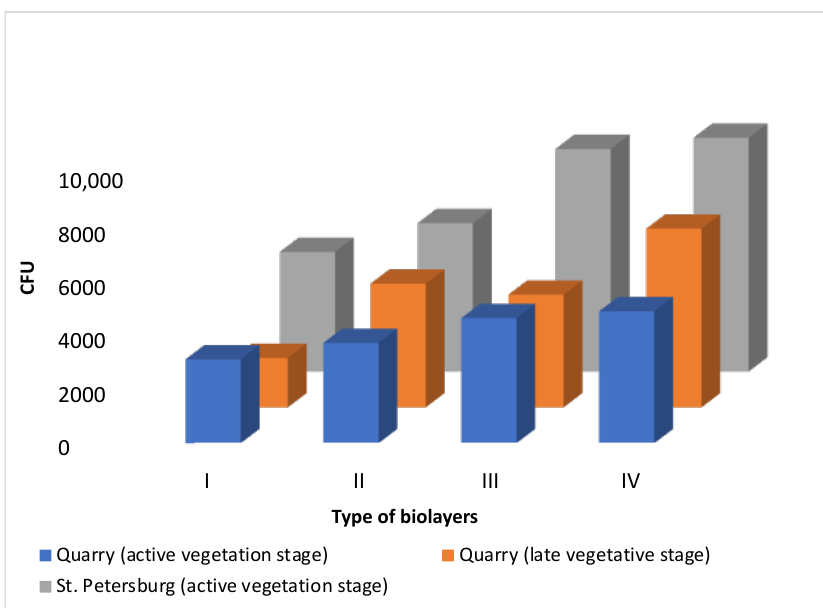
Figure 5. CFU number of micromycetes in different types of biolayers.